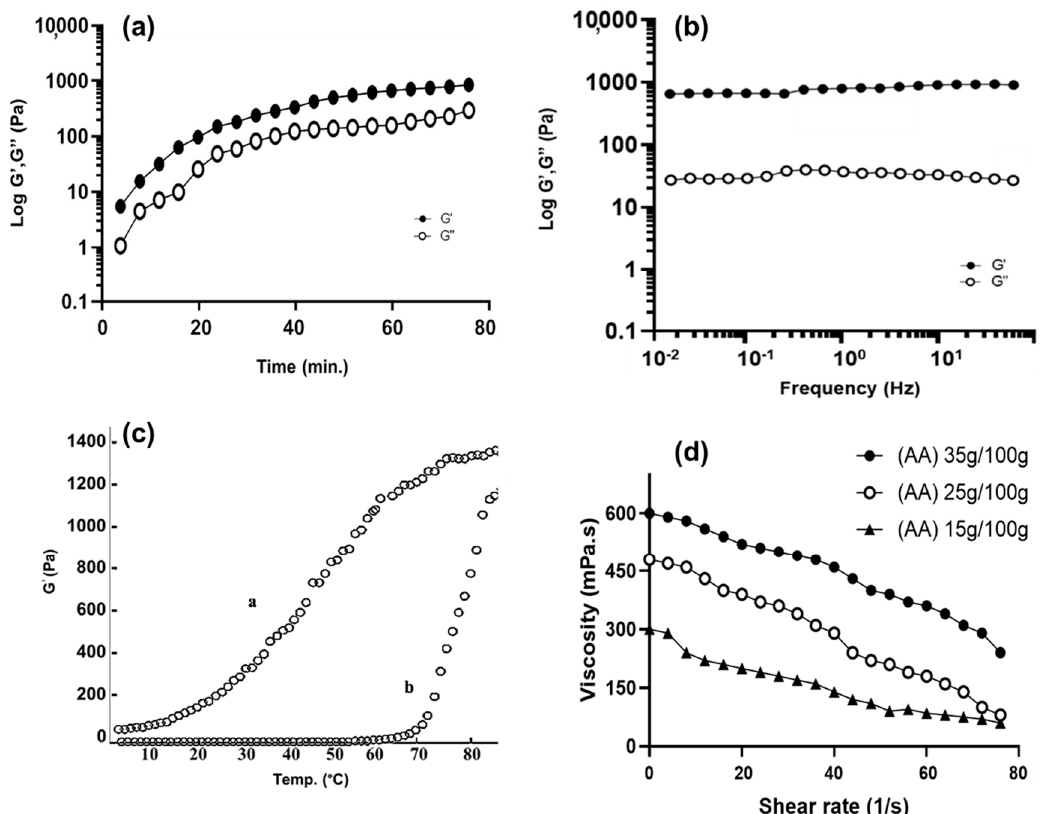
Figure 7. ( a ) Time sweep of BSG–co–poly (AA) hydrogels ( b ) frequency sweep of BSG–co–poly (AA) hydrogels ( c ) temperature sweep test of BSG–co–poly (AA) hydrogels solution ( d ) flow behavior test (viscosity vs. shear rate) of BSG–co–poly (AA) hydrogels.